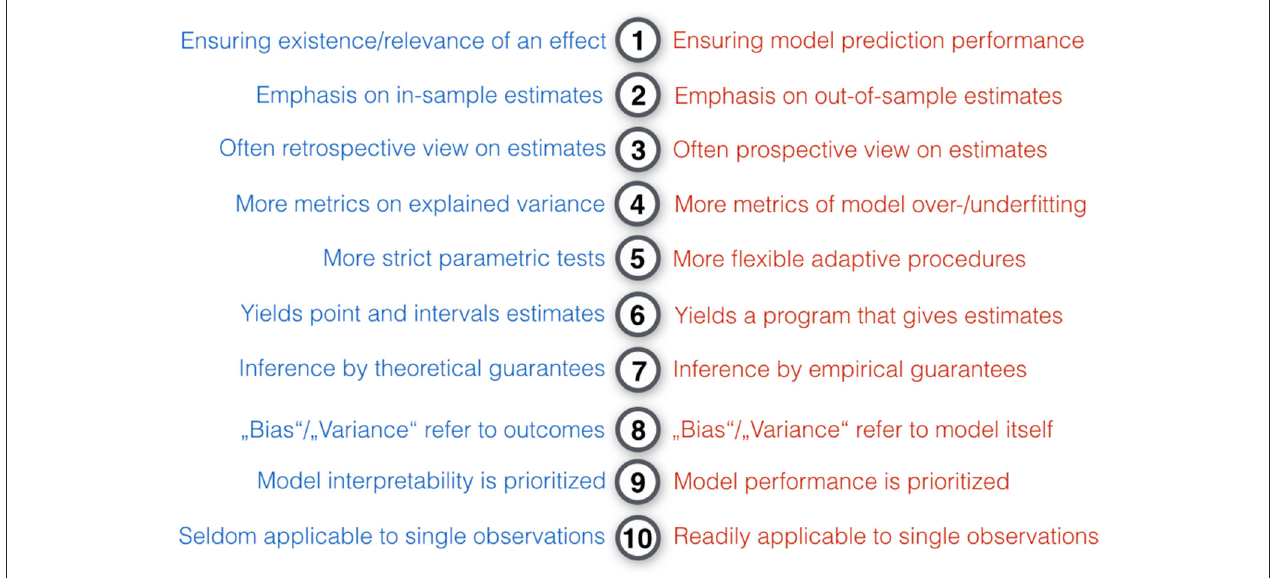
FIGURE 5 | Key differences between measuring outcomes in classical statistics and statistical learning. Ten intuitions on quantifying statistical modeling outcomes that tend to be relatively more true for classical statistical methods (blue) or pattern-learning methods (red). ClSt typically yields point estimates and interval estimates (e.g., p -values, variances, confidence intervals), whereas StLe frequently outputs a function or a program that can yield point and interval estimates on new observations (e.g., the k -means centroids or a trained classifier’s decision function can be applied to new data). In many cases, classical inference is a judgment about an entire data sample, whereas a trained predictive model can obtain quantitative answers from a single data